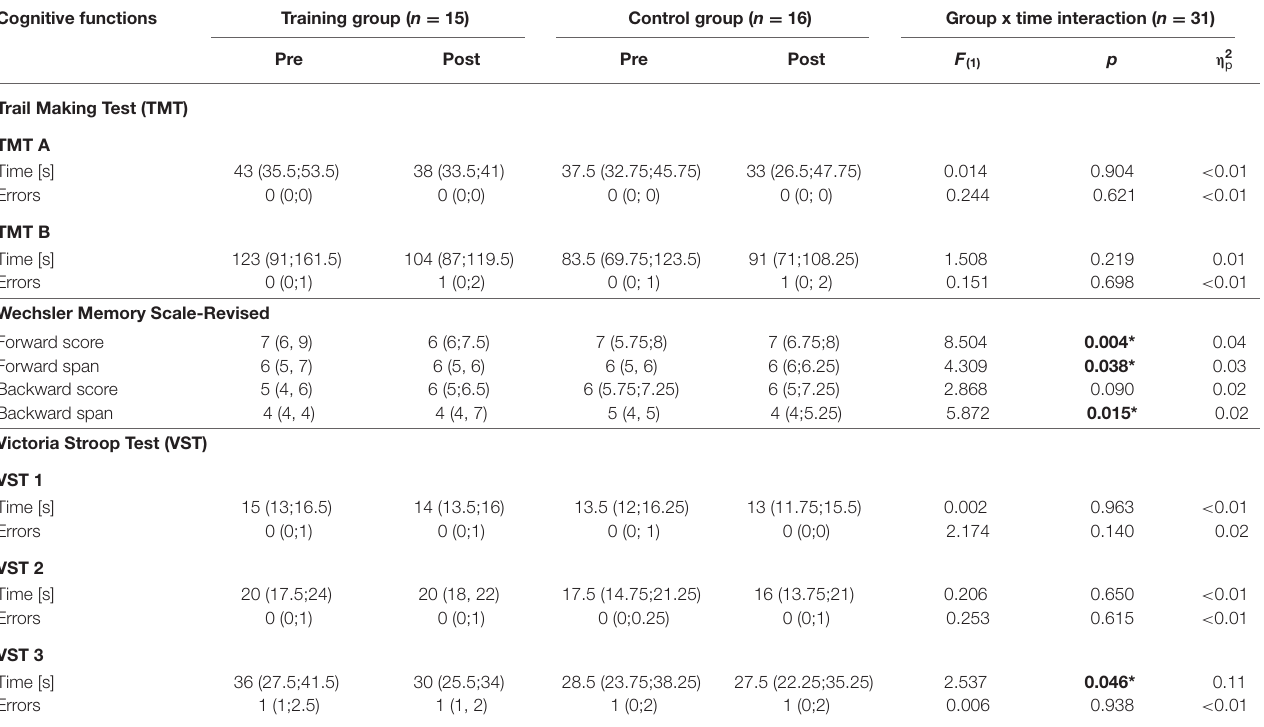
TABLE 3 | Interaction effects (group x time) in cognitive functions. Cognitive functions